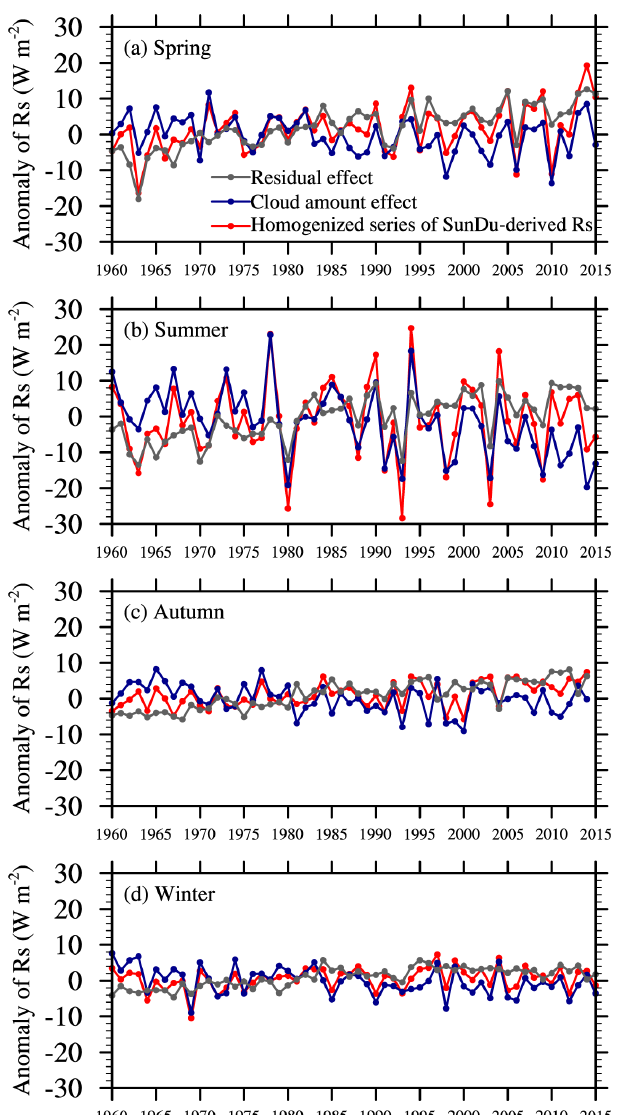
Figure 14. Same as Fig. 12 but for the four seasons. The decrease in Asian spring dust may have triggered the brightening over Japan for 1961–2015, as the R s in spring increases most among the